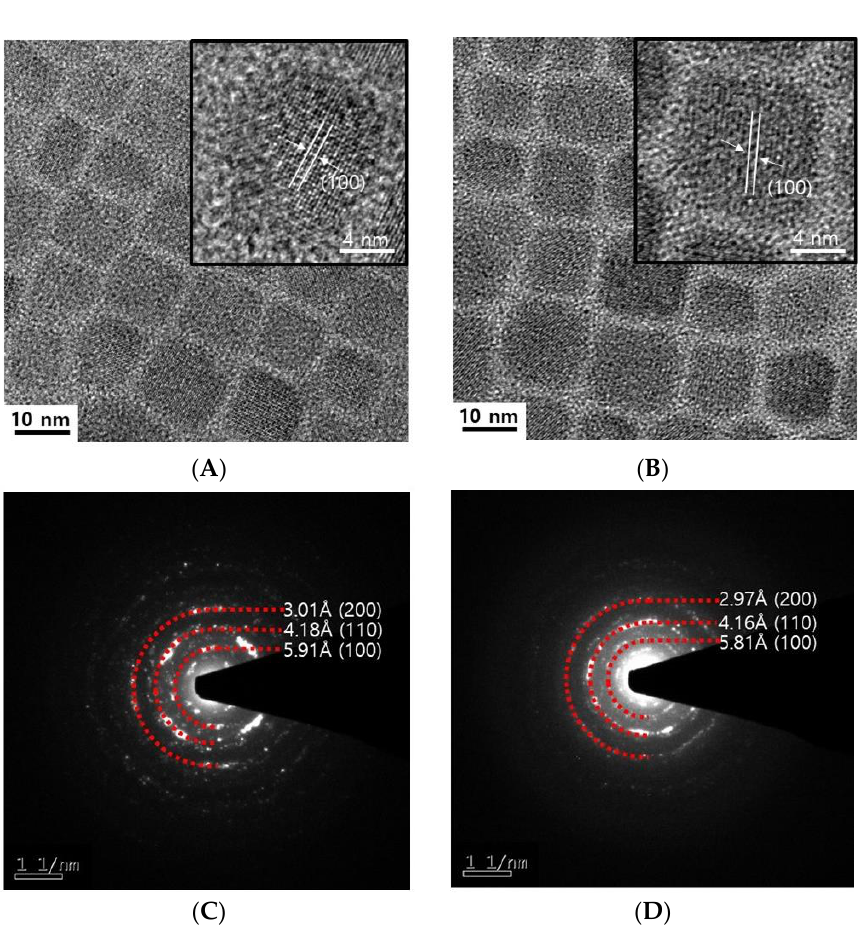
Figure 2. ( A , B ) Tunneling electron microscopic (TEM) images of ( A ) CsPbI 3 perovskite quantum dots (PQDs) with using commercial PbI 2 with 99.99% purity and ( B ) with using crystallized PbI 2 through hydrothermal. Insets show an enlarged single PQD with lattice fringe. ( C , D ) Selected area electron diffraction (SAED) of CsPbI 3 PQDs with using commercial PbI 2 with 99.99% purity ( C ) and with using crystallized PbI 2 through hydrothermal ( D